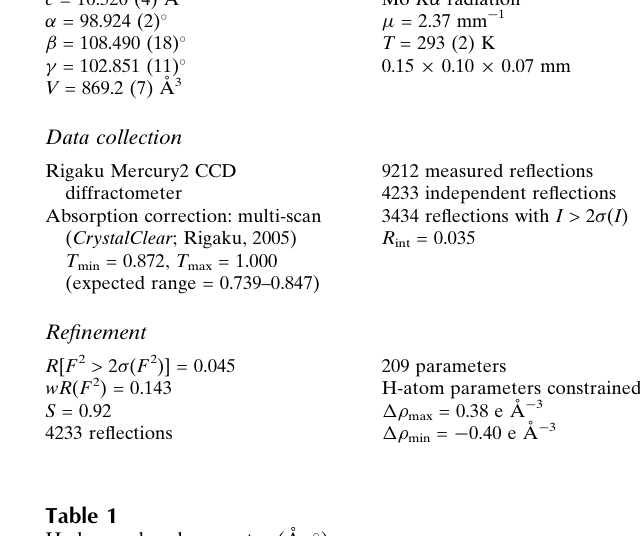
Hydrogen-bond geometry (A˚ , (cid:3)